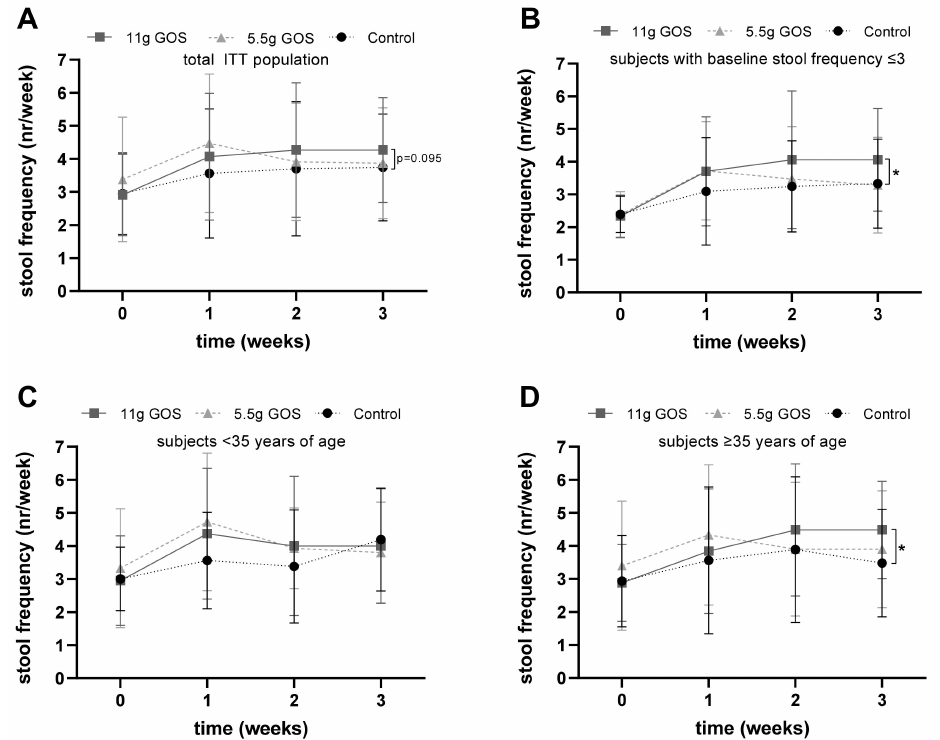
Figure 2. Stool frequency during the intervention period of ITT population, ( A ) Overview of the total ITT population for the • control group ( n = 43), ν 11 g GOS group ( n = 44), and the 5.5 g GOS group ( n = 45). Mixed model analysis showed a trend towards significance ( p = 0.095) between the control and 11 g GOS groups at week 3. ( B ) Subjects from ITT population with a basal stool frequency ≤ 3, for the • control group ( n = 33), ν 11 g GOS group ( n = 33), and the 5.5 g GOS group ( n = 32). Mixed model analysis showed a significant difference * ( p = 0.027) between the control and 11 g GOS groups at week 3. ( C ) Subjects from ITT population <35 years of age • control group ( n = 16), ν 11 g GOS group ( n = 19), and the 5.5 g GOS group ( n = 15). No significant differences were found in the subjects <35 years of age after mixed model analysis. ( D ) Subjects ≥ 35 years of age for the • control group ( n = 27), ν 11 g GOS group ( n = 25), and the 5.5 g GOS group ( n = 30). Mixed model analysis showed a significant difference * ( p = 0.010) between the control and 11 g GOS groups in subjects ≥ 35 years of age at week